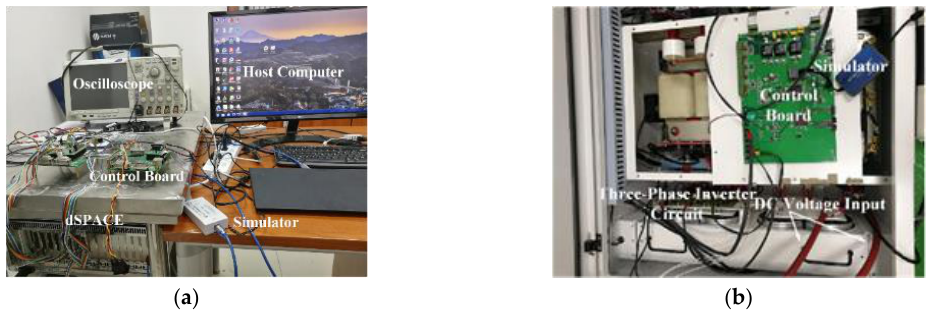
Figure 12. Experimental test bench: ( a ) hardware in the loop (HIL) simulation; ( b ) Practicality experiment.